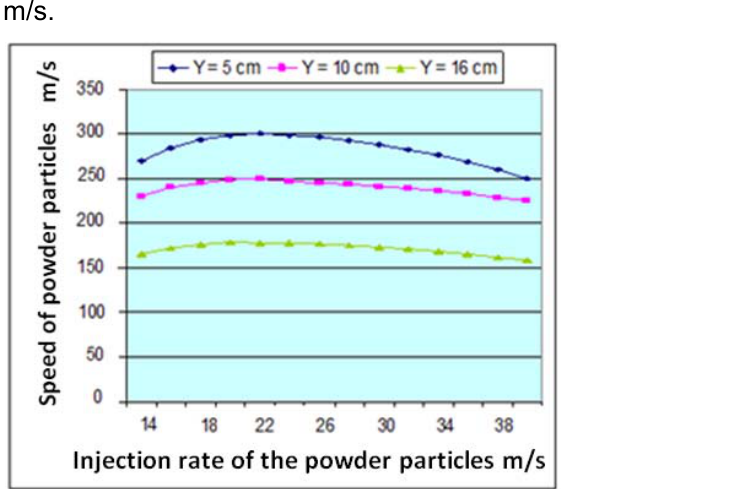
Figure 1 – Speeds particles in the plasma depending on the speed of injection and the substrate distance